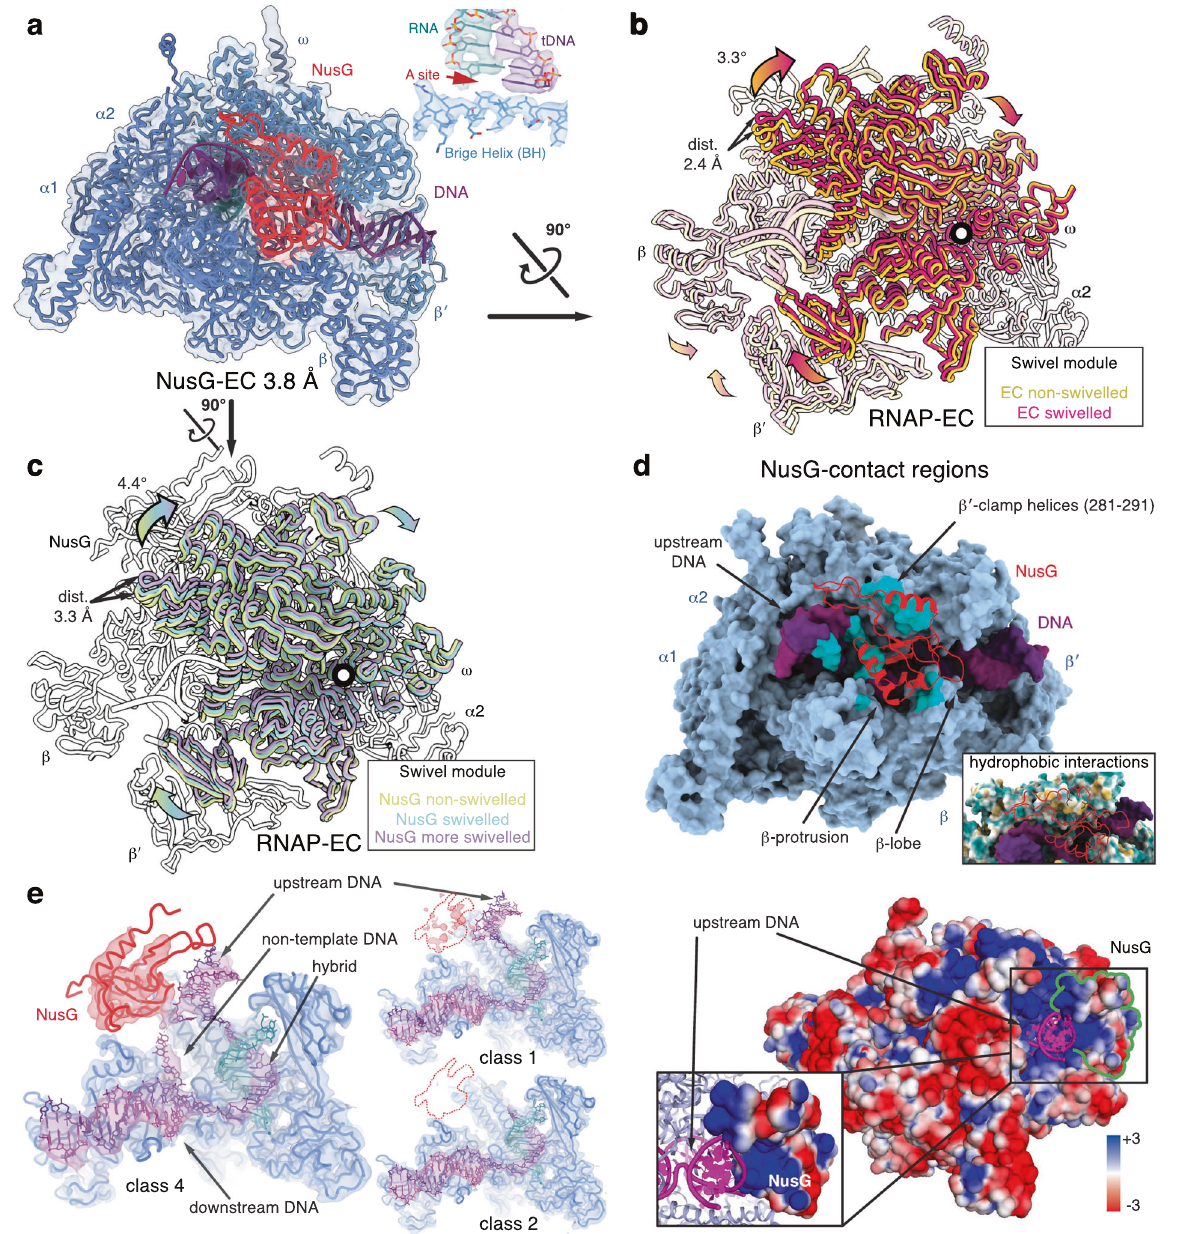
Fig. 1 Structures of the NusG elongation complex (NusG-EC). a Consensus reconstruction of NusG-EC at 3.8 Å resolution and re fi ned atomic model (left) shows the active site in a canonical post-translocated state (inset). NusG is coloured red, RNAP blue, DNA purple and RNA green. b , c 3D-classi fi cation resulted in 5 classes. b Classes 1 and 2 lack NusG (yellow and peach). The swivel module of these RNAP-ECs rotates up to 3.3° in comparison to the reference (PDB ID 6RH3). Comparing RNAP-EC class 1 and class 2, we observe 2.4 Å displacements furthest from the rotation axis. c Structural superpositions based on RNAP core module of classes 3 to 5 (light-green, cyan and purple), which contain strong NusG density and differ in their swivel module orientation. The swivel module rotates up to 4.4° (class 5) in comparison to the reference (PDB ID 6RH3, only one core module is shown for clarity in white). The swivel module rotations within classes 3 to 5 result in maximum displacements of 3.3 Å. d NGN (red) interacts with indicated regions of RNAP (turquoise) and provides a positively charged surface (bottom panel) that stabilises the upstream DNA (purple). e NusG (red) stabilises the upstream DNA duplex and the non-template DNA in the transcription bubble. Electron density of non-template DNA for NusG-containing class 4 (left) and classes lacking NusG